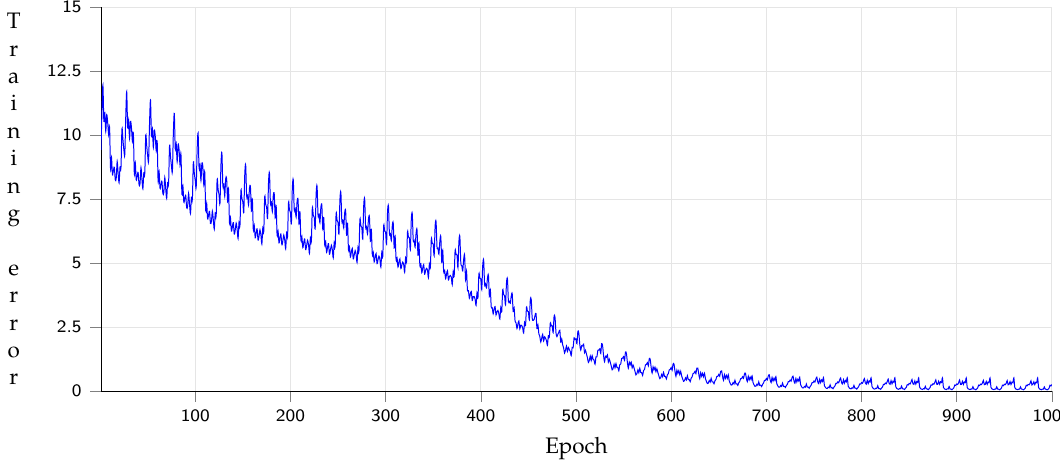
Figure 26. Training behavior of transfer learning